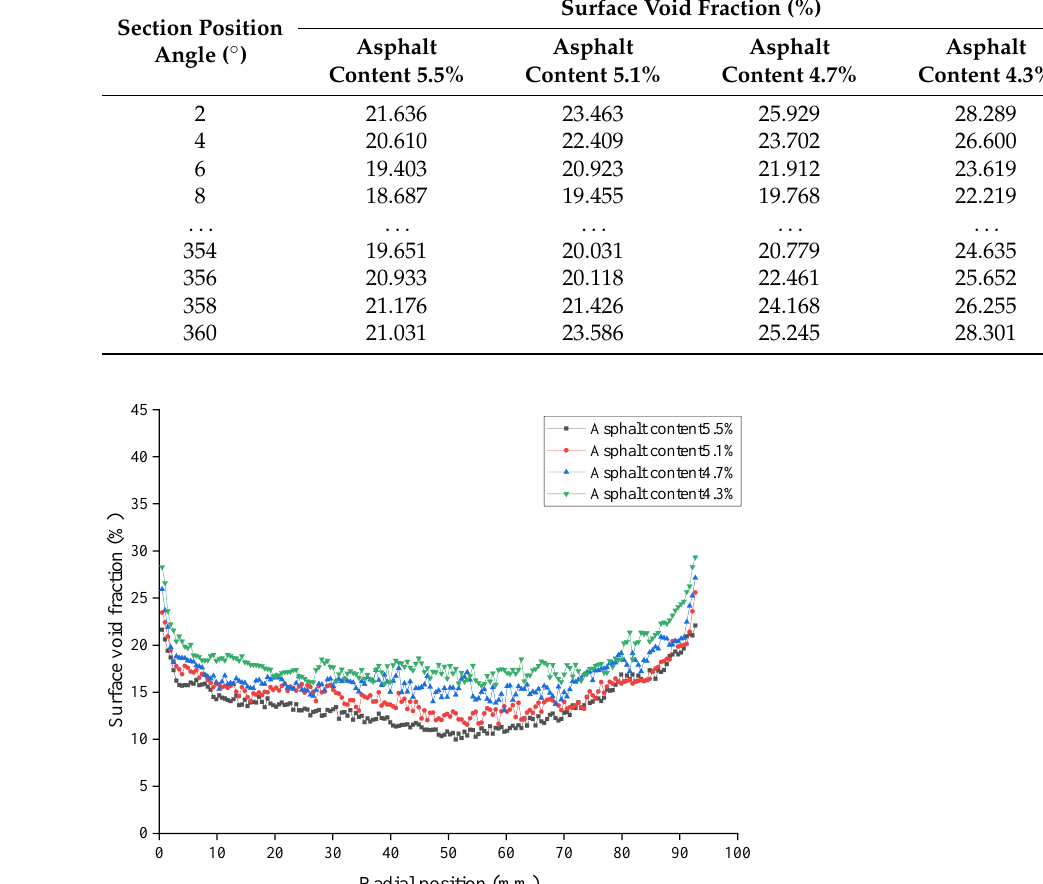
Figure 7. Surface void fraction distribution trend of EPA-13 radial section position.